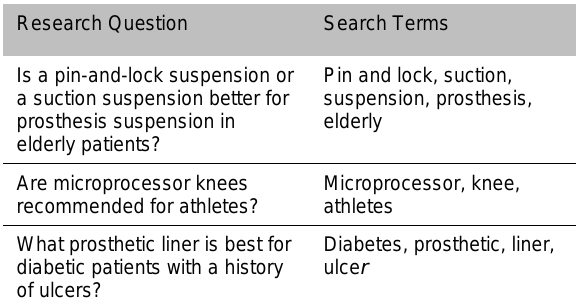
Table 1: Research questions and search terms used in Google